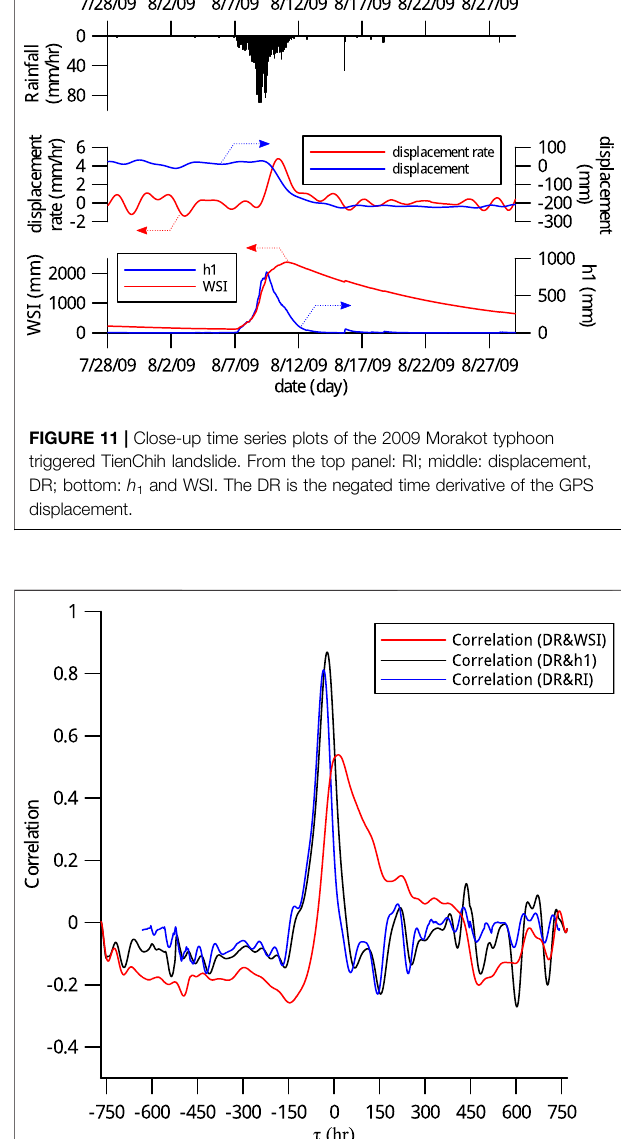
Frontiers in Earth Science |